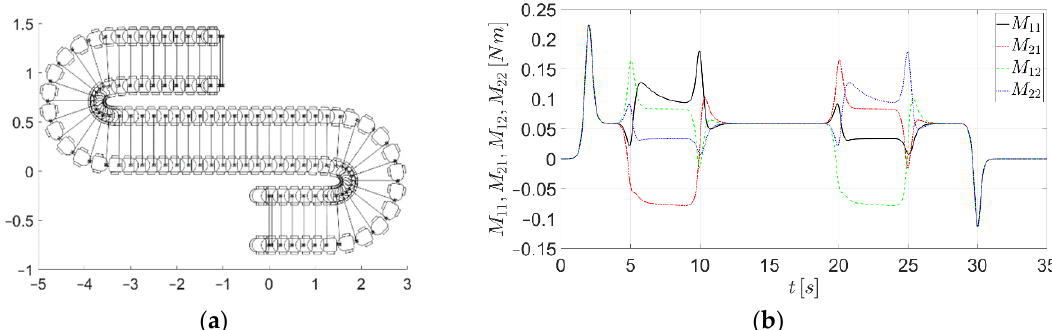
showing the shape of the formation of robots at successive points in time, as presented in Figure 6b. The frequency of generation of successive images by the emulator was 2 Hz.